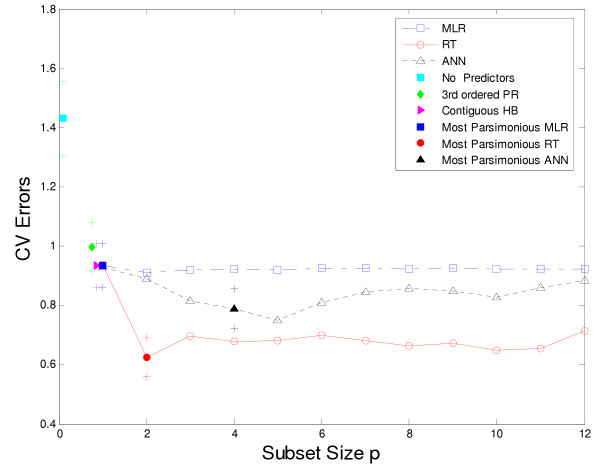
Cross-validation errors of the multivariate models. Cross-validation errors [Equation (4)] among the three multivariate models (MLR, RT, and ANN) and the third-order polynomial regression [11]. The chosen optimal model for each of the three multivariate methods is labeled with enlarged solid symbols with "+" indicating one standard error of the CV errors. The linear model using the most contiguous hydrogen bond (by treating GC as 3 hydrogen bonds and AT as 2 hydrogen bonds as used in Wren et al.; labeled as contiguous HB) had comparable performance as the linear model using most contiguous base pair as the sole predictor (MLR when p = 1). The cross-validated variance of TY, labeled as "no predictors", is 1.43 ± 0.13. Regression tree with two variables, X11 and X4, outperformed the other multivariate and univariate models.